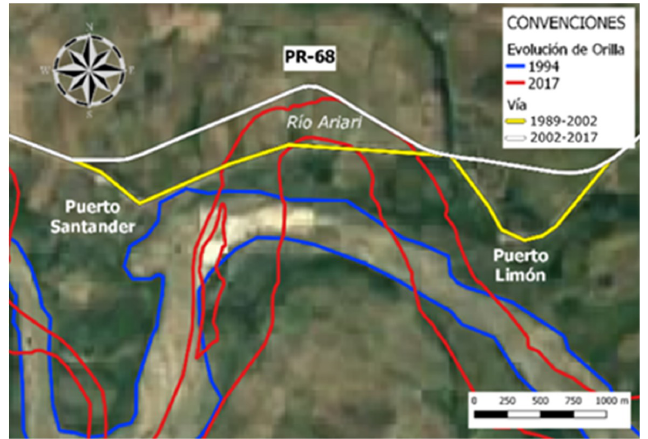
Figure 23. Ariari River, PR68: Position of the riverbed in 1994 and 2017, with respect to the original